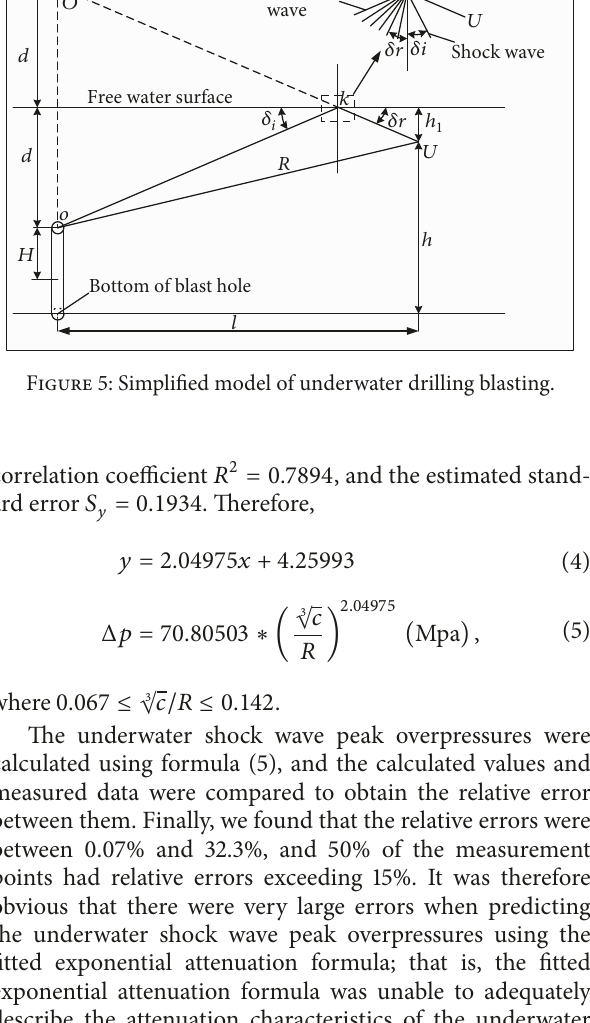
times, did not reach the measurement points at the same time.